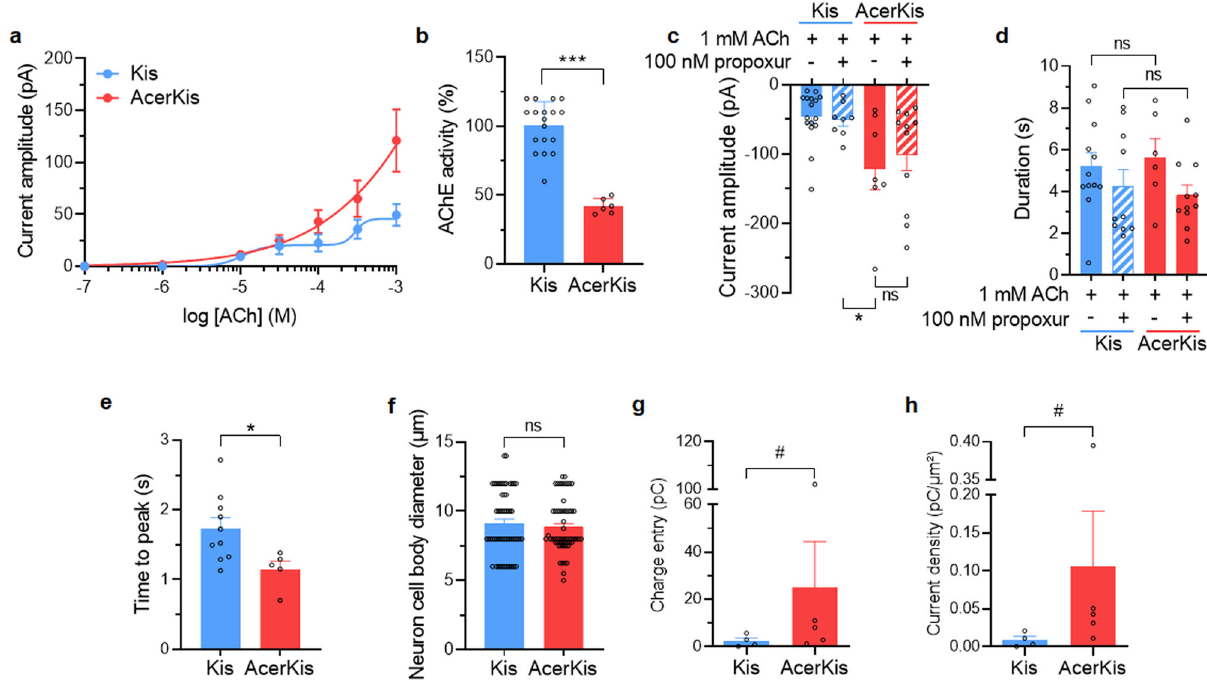
Fig. 2 Acetylcholine induces higher current amplitude in neurons isolated from Anopheles gambiae strain AcerKis. a Superimposed semilogarithmic dose-response curves for the ACh-induced currents recorded at a holding potential of − 50 mV in isolated neurons from mosquito strains Kis ( n = 5 – 15) and AcerKis ( n = 3 – 14), as indicated in the graph. Data are mean ± S.E.M. b Comparative histogram illustrating the % acetylcholinesterase (AChE) activity determined spectrophotometrically in neurons isolated from Anopheles gambiae Kis ( n = 18) and AcerKis ( n = 6) strains. Bars represent mean ± S.D; Statistical test used was Student unpaired t -test, *** p < 0.001. Note the strong reduction in AChE activity measured in AcerKis neurons. c , d Histograms summarizing the effects of the carbamate insecticide, propoxur (100 µ M), known to inhibit acetylcholinesterase, on both current amplitudes ( c ) and durations ( d ) evoked by ACh (1 mM, 3 s in duration). The current duration was measured at 50% of the amplitude. Bars represent mean ± S.E.M. ( n = 6 – 16); Statistical test used was Student unpaired t -test, * p < 0.05; ns, non-signi fi cant. e The time to peak of the ACh-induced inward current recorded in AcerKis neurons was compared to that of measured in Kis neurons. Bars represent mean ± S.E.M. ( n = 5 – 10); Statistical test used was Student unpaired t -test, * p < 0.05. f Comparison of cell body diameters between neurons isolated from Kis ( n = 56) and AcerKis ( n = 57) strains. Bars represent mean ± S.E.M. Statistical test used was the Mann – Whitney test, ns, non-signi fi cant. g , h Comparative histograms illustrating the charge density ( g ), calculated from the integral of the current according to the Eq. (3) and the current density ( h ) measured from the ACh-evoked inward current recorded in Kis and AcerKis neurons. Bars represent mean ± S.E.M ( n = 4 – 5), Statistical test used was the Mann – Whitney test # p < 0.02. In all cases, the number of experiments ( n ) are biologically independent